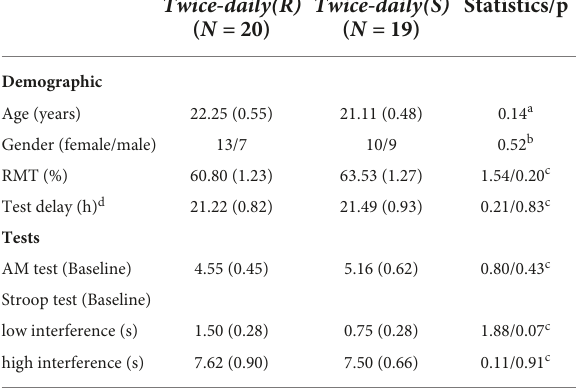
TABLE 1 Characteristics of participants from twice-daily